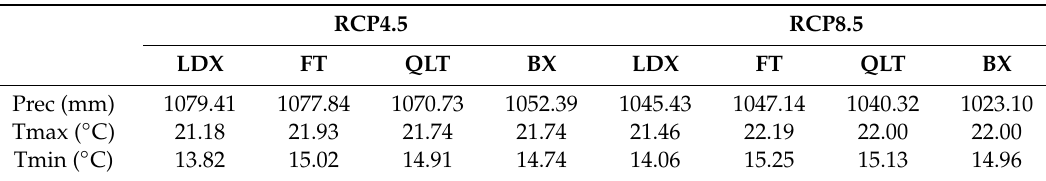
Table 4. The annual mean precipitation and maximum and minimum temperatures of the four sub-basins in 2021–2040 under the scenarios of Representative Concentration Pathway (RCP)4.5 and RCP8.5. RCP4.5 RCP8.5 LDX FT QLT BX LDX FT QLT BX Prec (mm) 1079.41